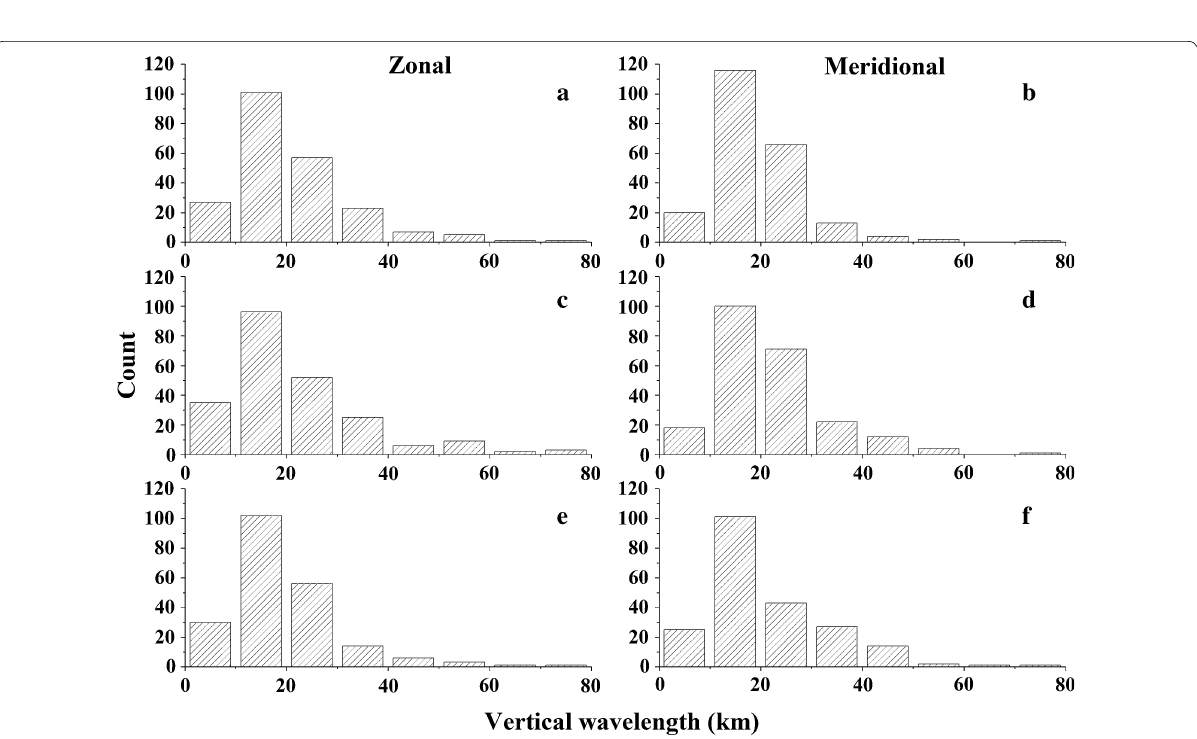
Fig. 11 Occurrence frequency of the vertical wavelength over the year for a zonal wind at CA, b meridional wind at CA, c zonal wind at CP, d meridional wind at CP, e zonal wind at SM and f meridional wind at